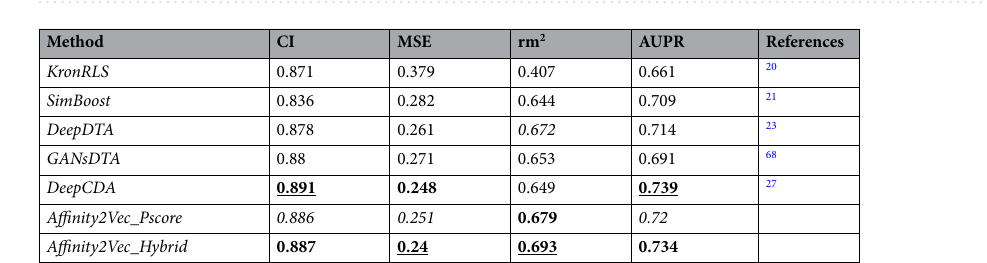
Figure 4. The average performance on the test set of each evaluation measurement (MSE, CI, rm2, and AUPR) across Davis and KIBA datasets for each method.